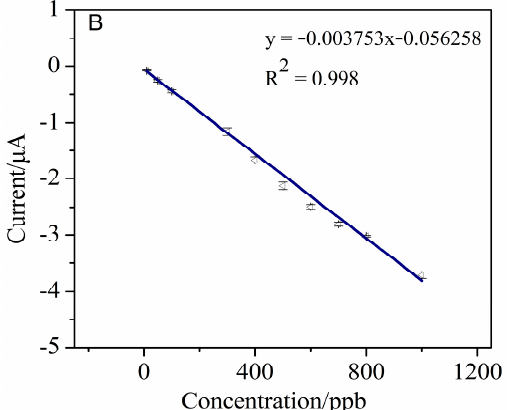
Figure 13. The response current curve for different concentrations of Cr (VI) solution of 0–1000 μ g/L (pulse size = 25 mV, frequency = 25 Hz, step size = 5 mV, 0.1 mol/L sodium acetate buffer, pH 6, AuNPs deposition time 300 s).